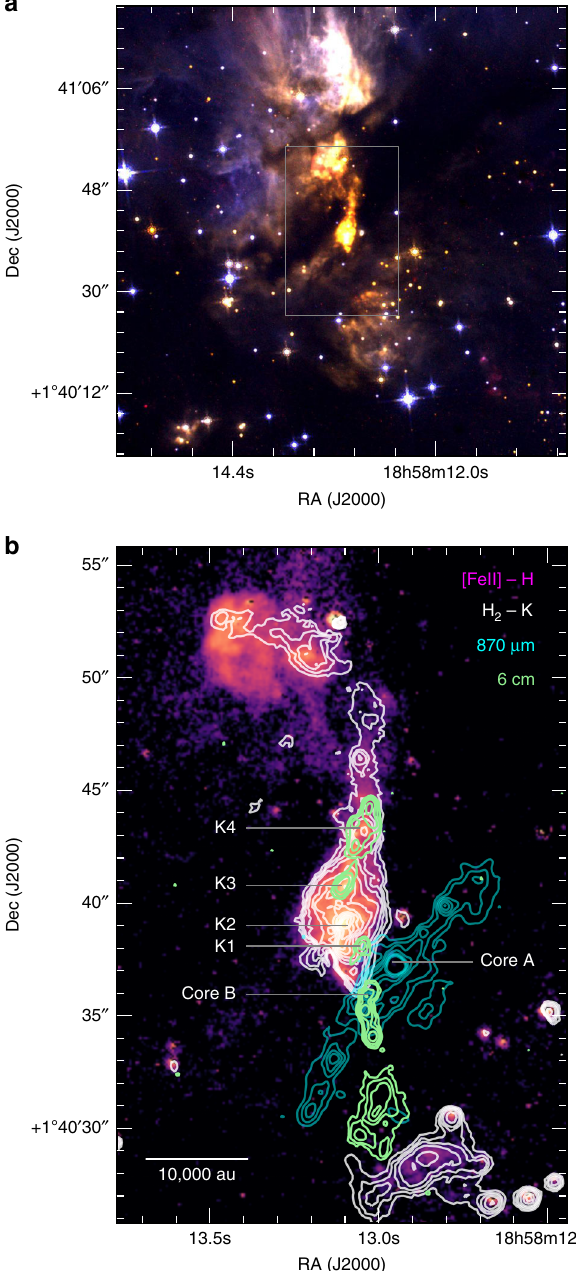
Fig. 1 G35.2-0.74N star formation complex. a Three colour composite HST image of the innermost region of the star-forming site G35.20-0.74N, revealing the jet from the massive protostar. Red channel is the [Fe II] 1.644 μ m narrow fi lter (F164N), green channel is the H 1.600 μ m wide fi lter (F160W), and blue channel is the J 1.100 μ m wide fi lter (F110W). b Composition of the HST/WFC3 (violet) image, VLT/ISAAC (white contours), ALMA (cyan), and VLA (green) datasets. In both panels, north is up and east is left. The position of the main cores in the region as well as the jet knots are labelled. The fi eld of view of panel b is indicated with a rectangle in panel